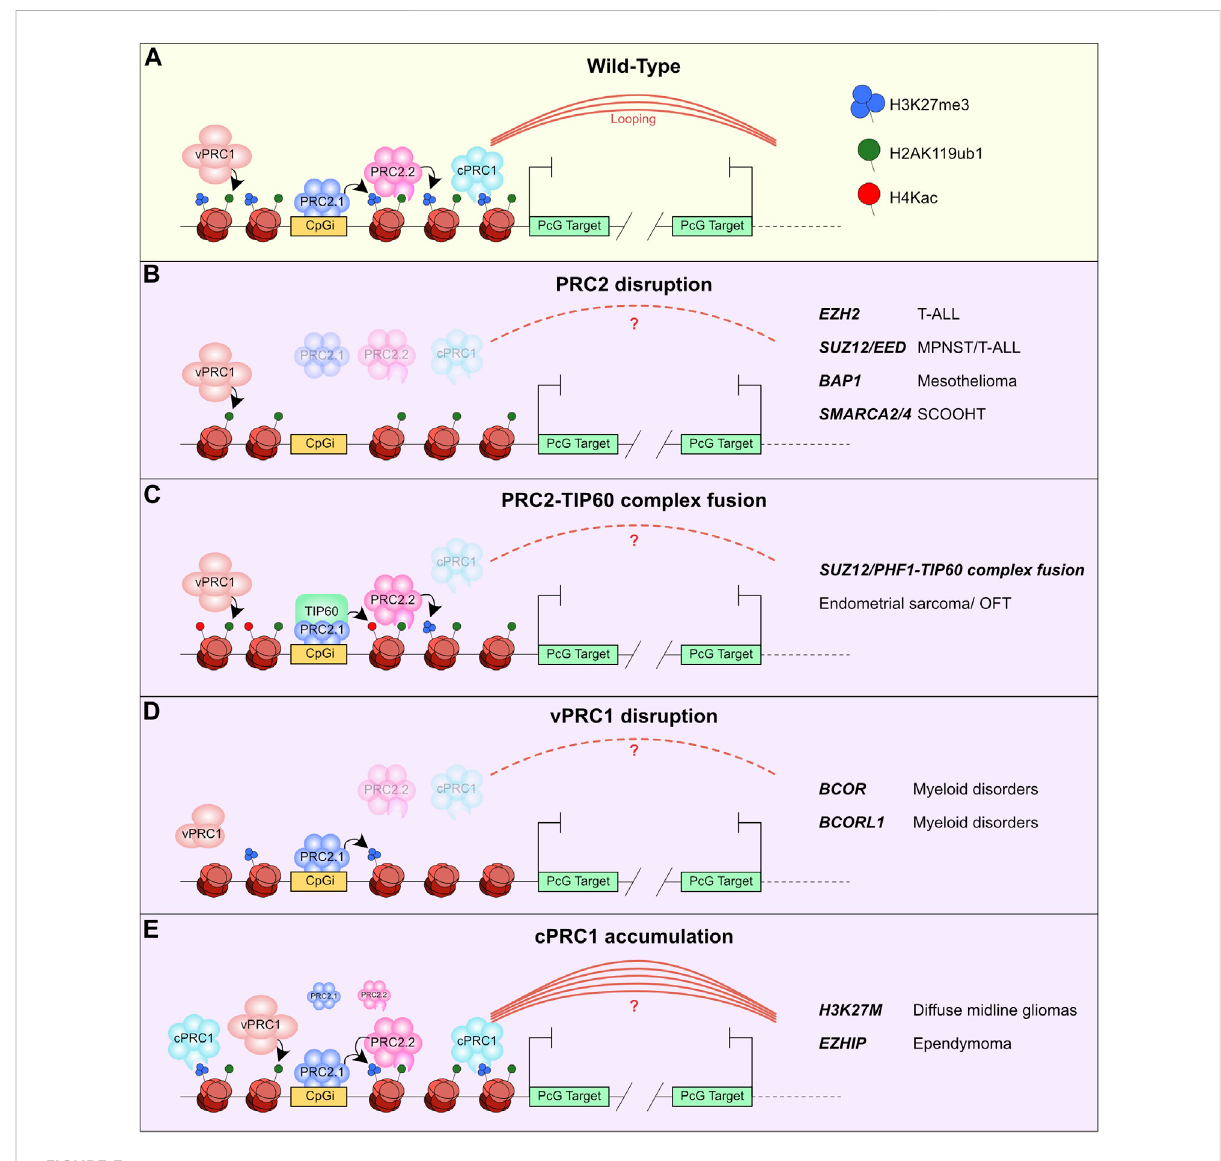
FIGURE 3 MalformationofPcGbodiesincancer. (A) SchematicofrecruitmentmodelforPRC1andPRC2complexes.i)vPRC1isrecruitedbytranscription factors or CpGi readers and catalyses H2AK119ub1. ii) PRC2.2 reads H2AK119ub1 and PRC2.1 is recruited to CpGi, these complexes catalyse H3K27me3. iii) cPRC1 reads H3K27me3 and promotes Polycomb mediated looping to other cPRC1 marked regions. (B – E) Illustration of how different mutations of PcG proteins in diverse cancer types affects the PcG recruitment pathway and in turn cPRC1 mediated looping. This includes (B) PRC2disruption, (C) PRC2-TIP60complexfusion, (D) vPRC1disruption, (E) andcPRC1accumulation.Thegenesmutatedandthecancer they are associated with are listed on the